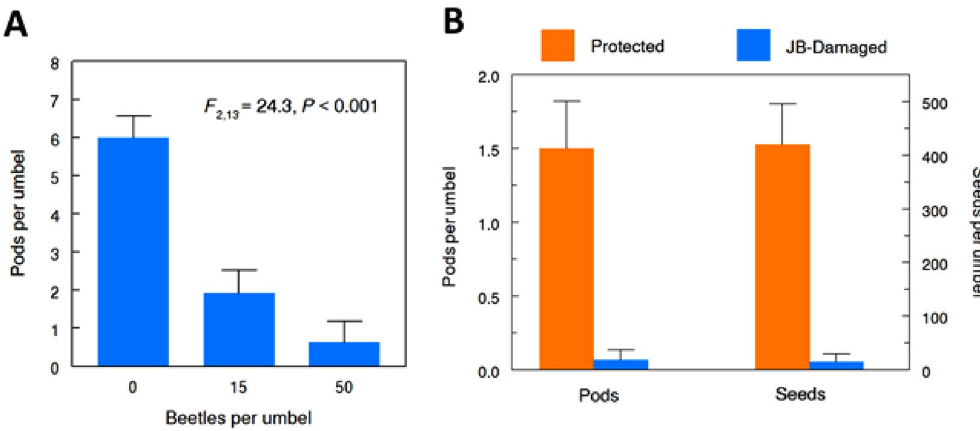
Figure 5. Japanese beetle [JB] feeding on umbels reduces milkweed fruiting and seed set. ( A ) Field-realistic densities of JB caged on intact umbels for 24 h reduced early fruit set. ( B ) Damage from natural JB aggregations greatly reduced numbers of mature pods and seeds (Wilcoxon rank sum test, P < 0.001). Bars represent means + standard